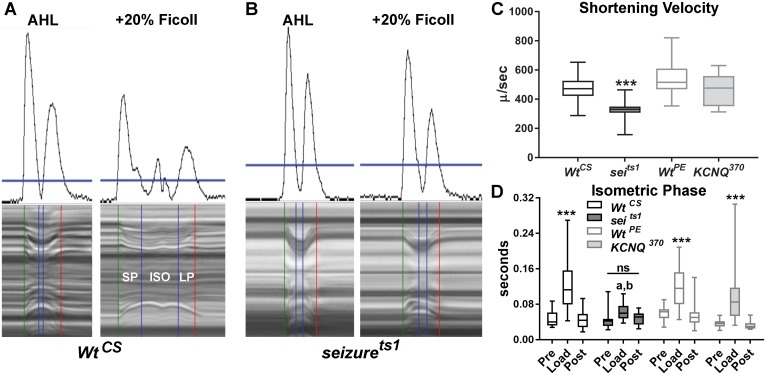
Cardiac contractility under loaded conditions.(A-AHL) Movement traces (top) and corresponding M-mode (bottom from a WtCS heart under unloaded conditions (normal AHL). Note that there are distinct movement peaks produced by the contraction and relaxation of the heart wall that are used along with a movable threshold bar (horizontal blue line in A & B) to accurately parse a single contraction into shortening (SP), isometric (ISO) and lengthening phases (LP). (A-+20% Ficoll) Hearts beating for 30 min under load (AHL + 20% Ficoll 400) show a prolonged shortening phase (SP) and an obvious isometric contraction phase (ISO). (B) Hearts from seits1 mutants do not exhibit a prolonged ISO phase under load. (C) Shortening velocities were calculated as (Diastolic Diameter-Systolic diameter)/ Shortening Phase, SP) see Cammarato et al, 2015. Under unloaded conditions Seits1 mutants showed significantly reduced shortening velocities compared to WtCS as well as to WtPE and KCNQ370 (a K+ channel mutant). (D) The length of time that hearts maintained isometric contractions was significantly increased under Load (plus 20% ficoll) for all genotypes except for sei mutants (ns = not significant; a-p<0.0001 with WtCS and WtPE; b-p<0.05 with KCNQ370). For C&D data are shown as the mean, 2.5–97.5% confidence interval, Maximum and Minimum values. Significance in (C) was determined using a one way ANOVA and in (D) using a two-way ANOVA, both with Tukey’s multiple comparisons post-hoc test, **p<0.01, ***p<0.001. (WtCS n = 16, seits1 n = 23, WtPE n = 24, KCNQ370 n = 16).